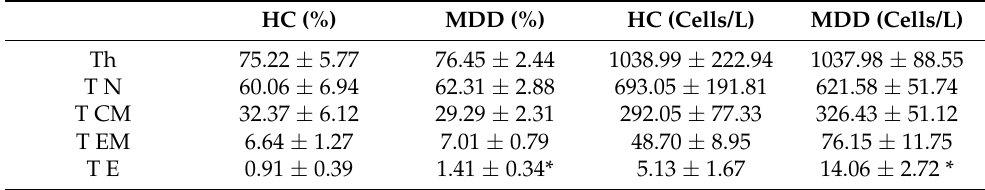
Table 2. Circulating CD4 + T lymphocytes in MDD patients. Circulating counts and percentages of subsets in MDD patients and HCs. * represent p < 0.05 between MDD patients and